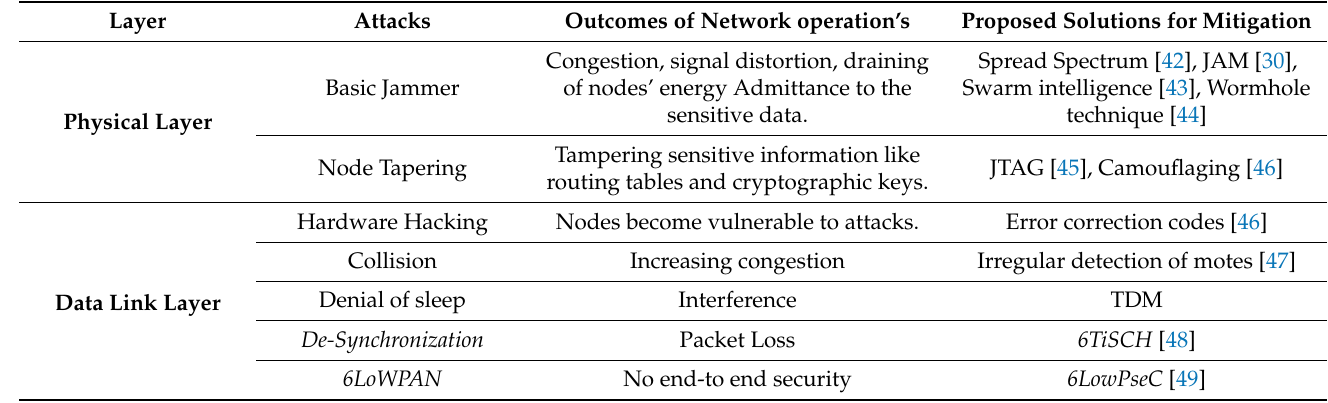
Table 3. Layer-wise cyber attacks in WSN and